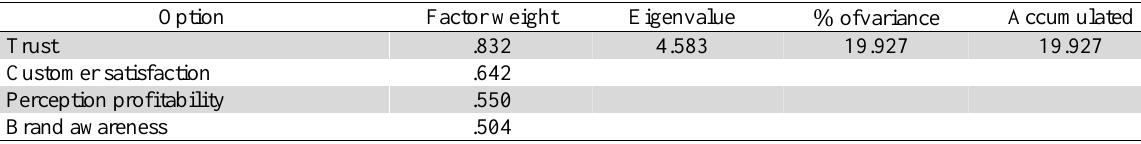
The summary of factors associated with brand